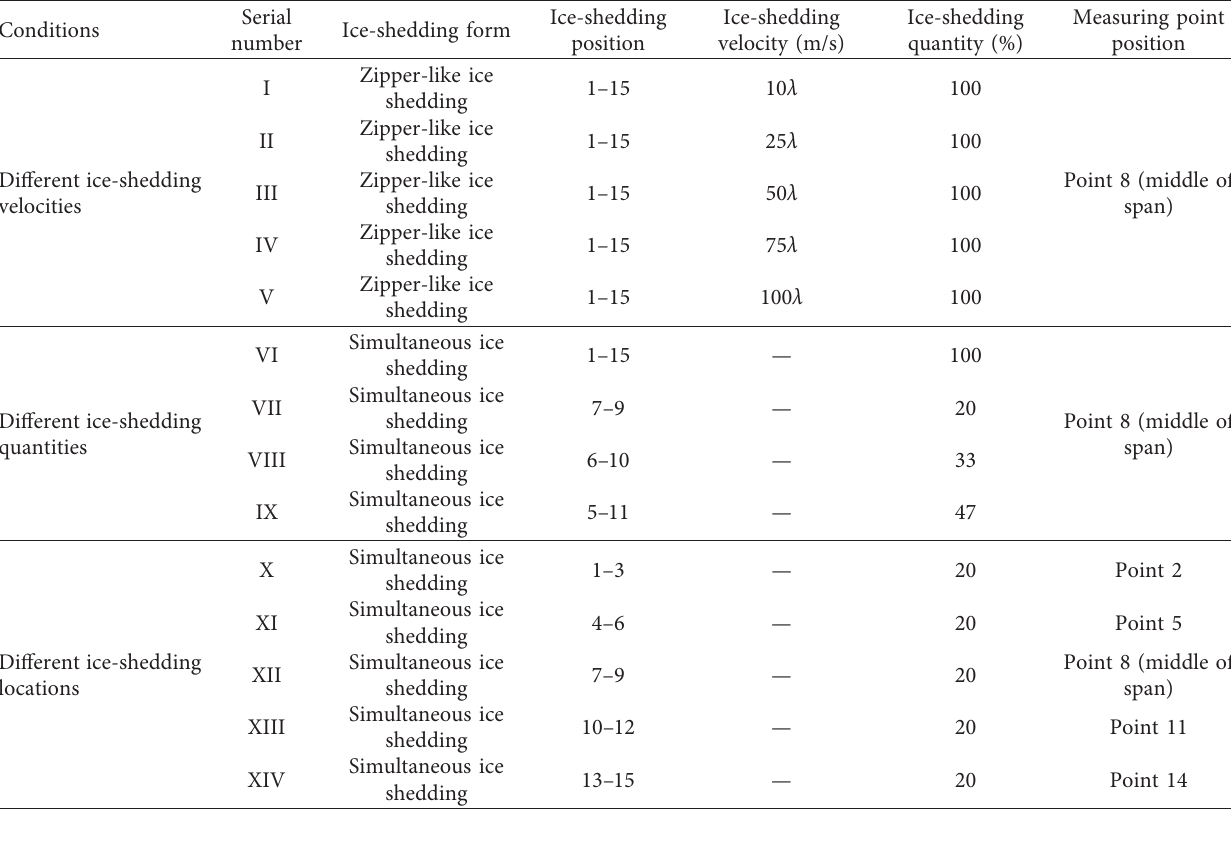
Table 4: Ice-shedding conditions of the model.